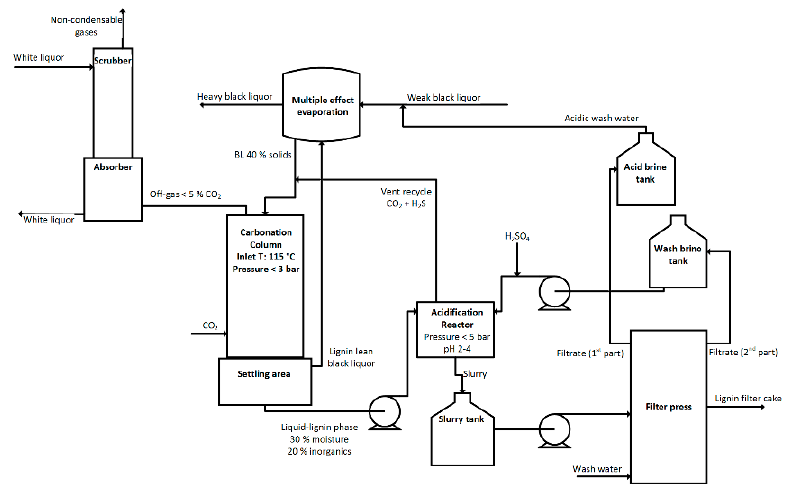
Figure 5. Schematic drawing of the SLRP process.